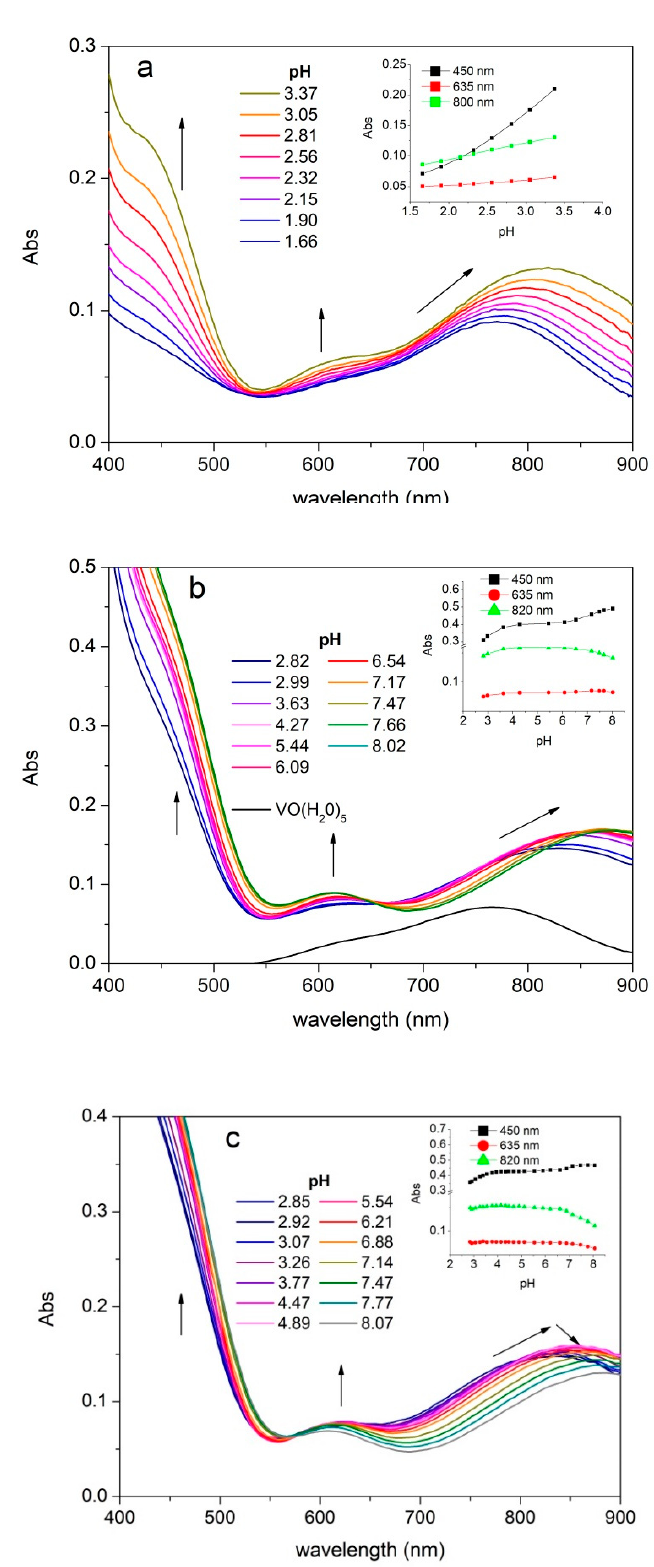
Figure 4. UV-vis absorption spectra. UV-vis absorption spectra of a solution containing oxovanadium(IV) 5 mmolL − 1 and S2 5 mmolL − 1 (batch titration) ( a ), S3 15 mmol L − 1 ( b ), and SC 15 mmol L − 1 ( c ). Inset graphs: Diagrams Abs vs. pH at different wavelengths.